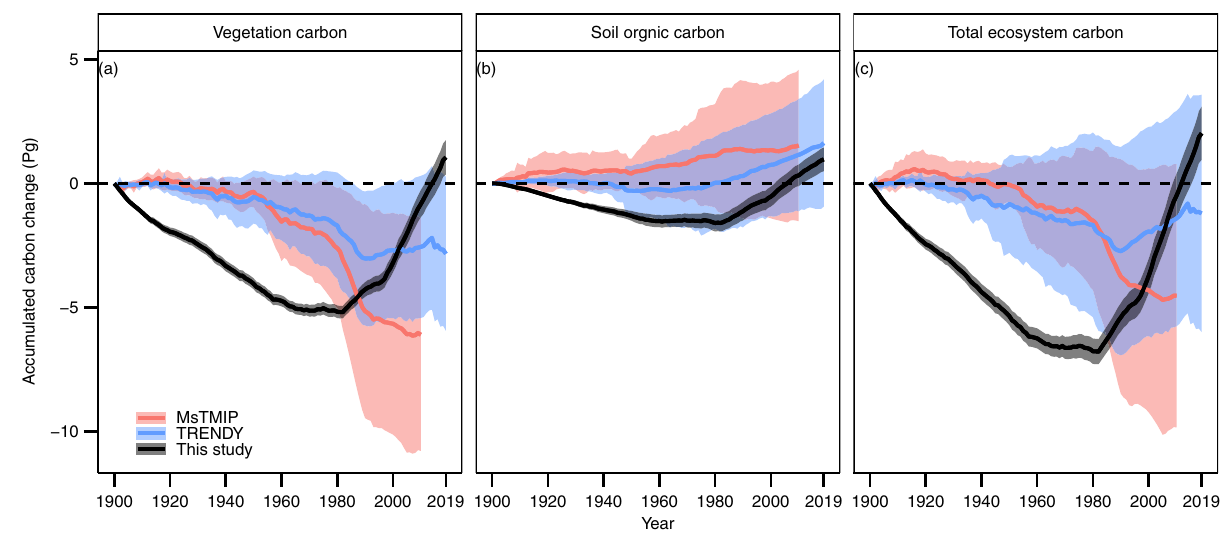
Fig.3|Temporalchangesofcarbonstoragefrom1900to2010sinChina. Panel a – c indicate vegetation carbon, soil organic carbon, and total ecosystem carbon, respectively. Results derived from experiment designed to have all environmental factors vary historically from 1900 to the 2010s, for model design details of this